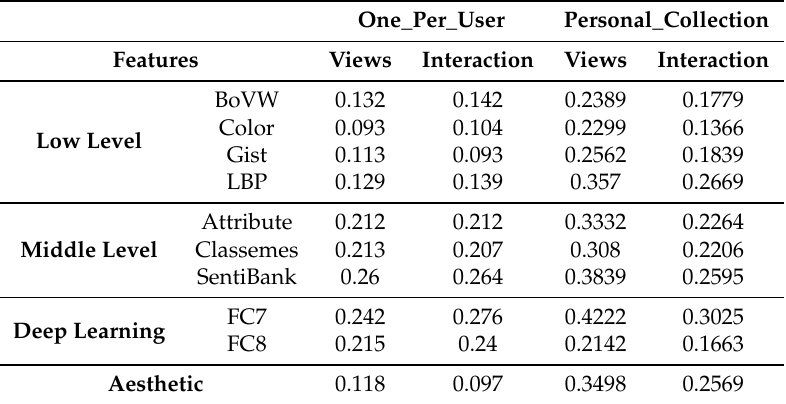
Table 6. Performance of visual features on the prediction of popularity for the one_per_user and Personal_collection